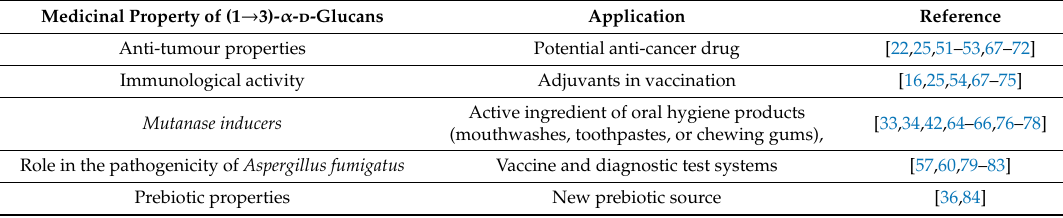
Table 3. Medical properties and potential application of fungal (1 → 3)- α - d -glucans. Medicinal Property of (1 → 3)- α - d